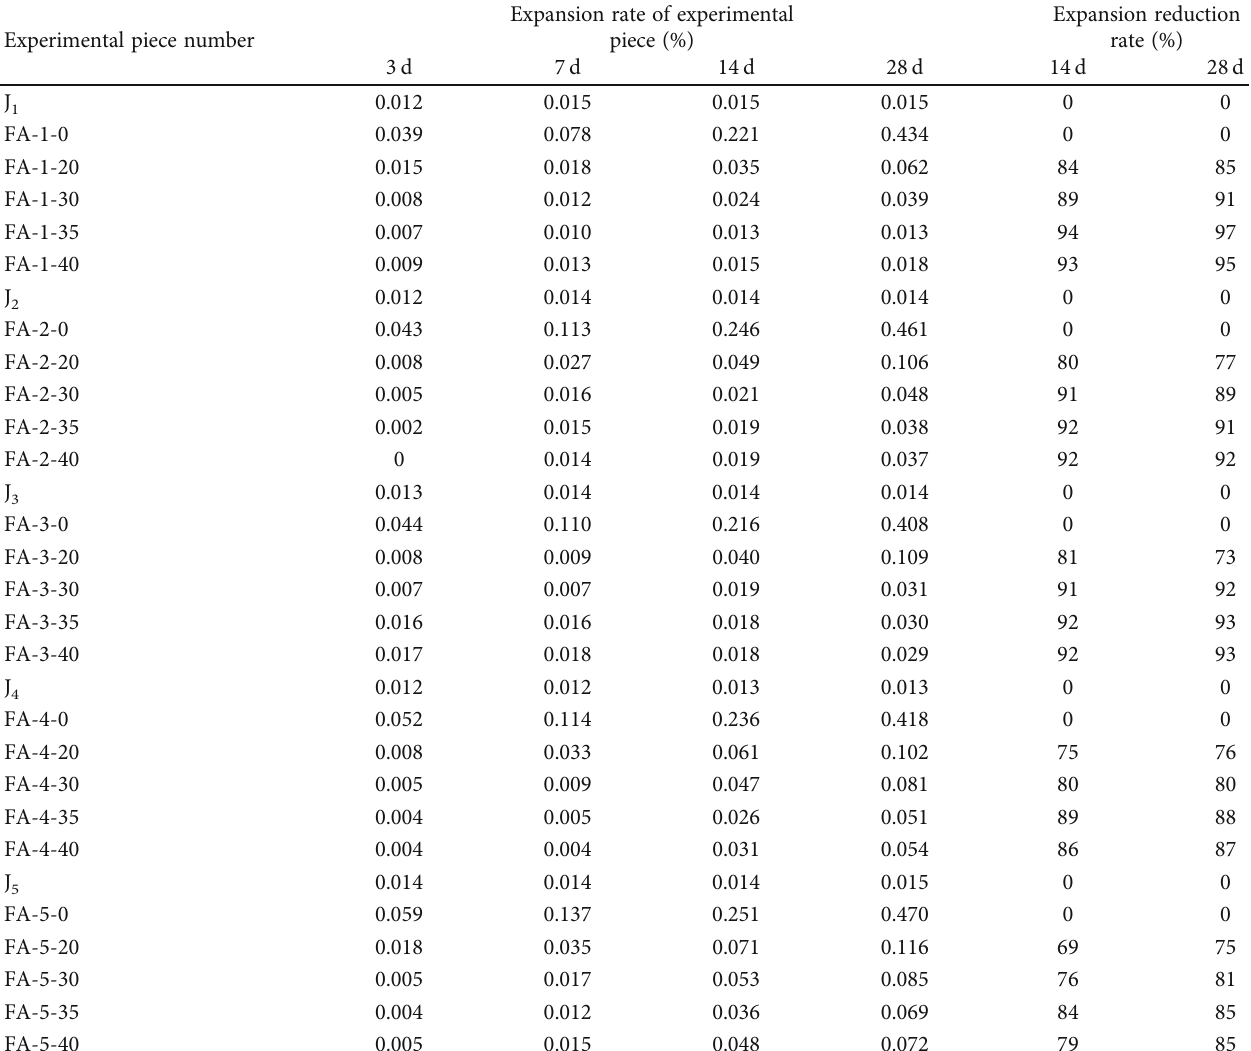
Table 5: Experimental